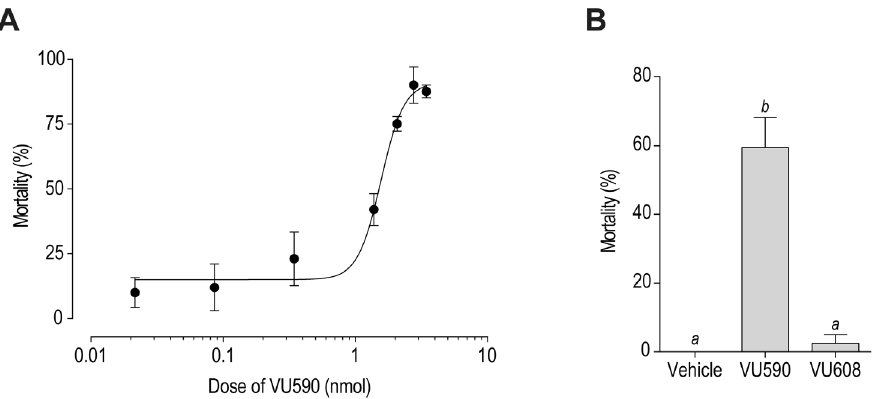
Figure 3. Effects of VU590 on the survival of adult female mosquitoes ( A.aegypti ). (A) Dose-response curve of the toxic effects of VU590 on mosquitoes (R 2 =0.87). Mortality was assessed 24 h after injecting the hemolymph with 69 nl of the vehicle (K + -PBS 50 with 15% DMSO, 1% b - cyclodextran, and 0.1% Solutol) containing appropriate concentrations of VU590 to deliver the doses indicated. The calculated LD 50 is 1.56 nmol (95% CI: 1.29–1.88 nmol). Values are means 6 SEM; n =4 trials of 10 mosquitoes per dose. (B) Comparison of the toxic effects of the vehicle, VU590, and VU608. Mortality was assessed 24 h after injecting the hemolymph with the vehicle (K + -PBS 75 with 15% DMSO, 1% b -cyclodextran, and 0.1% Solutol) or the vehicle containing a small molecule (2.8 nmol). Values are means 6 SEM; n =4 trials of 10 mosquitoes. Lower-case letters indicate statistical categorization of the means as determined by a one-way ANOVA with a Newman-Keuls posttest ( P , 0.05).